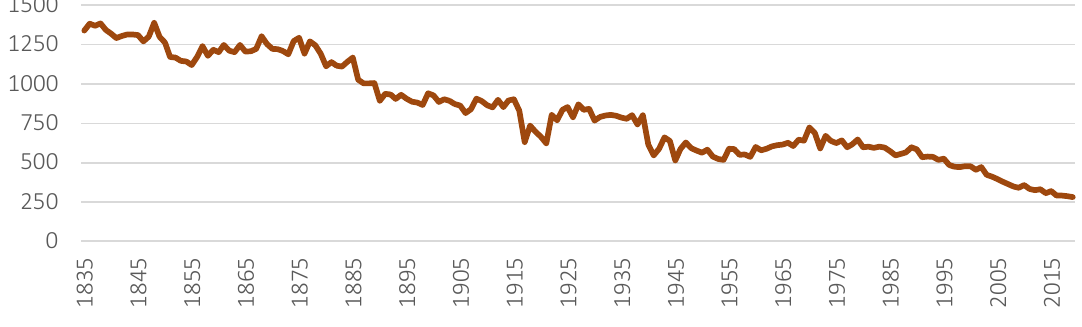
Figure 3a. Energy intensity in Gigajoule derived units per GDP in 2015-NOK